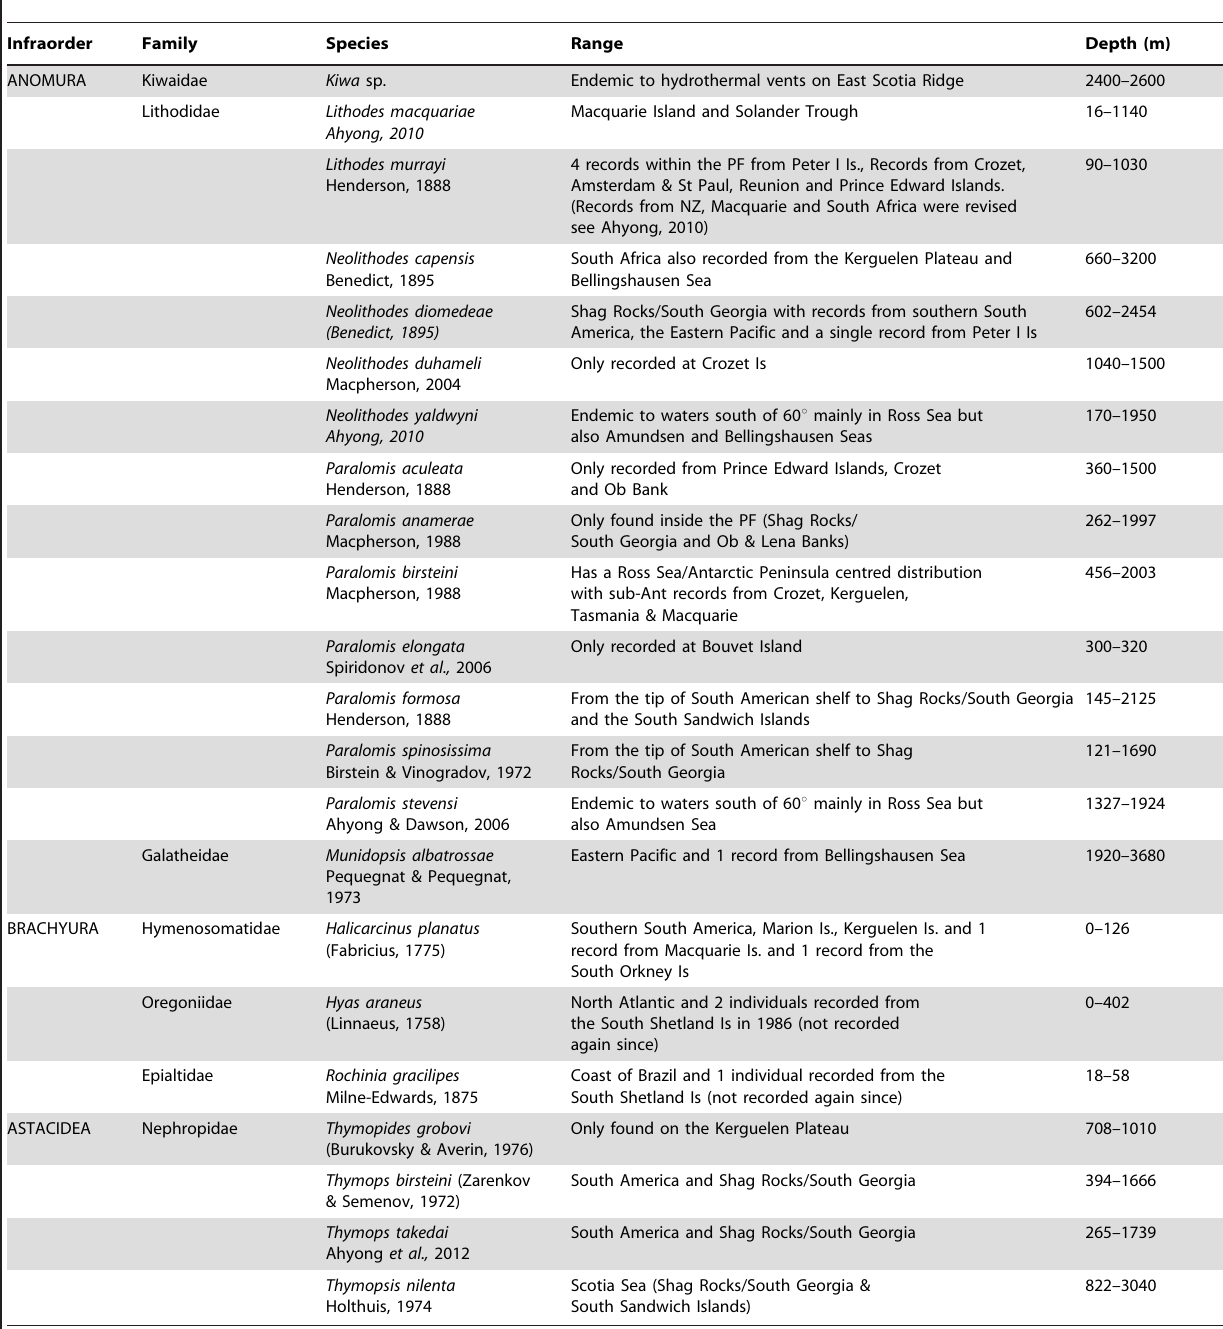
Table 1. Classification and distribution of Recent Southern Ocean crabs and lobsters. Classification taken from De Grave et al.,